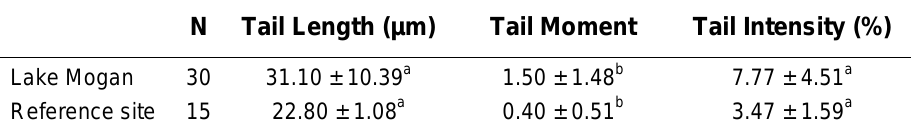
The Results of the Comet